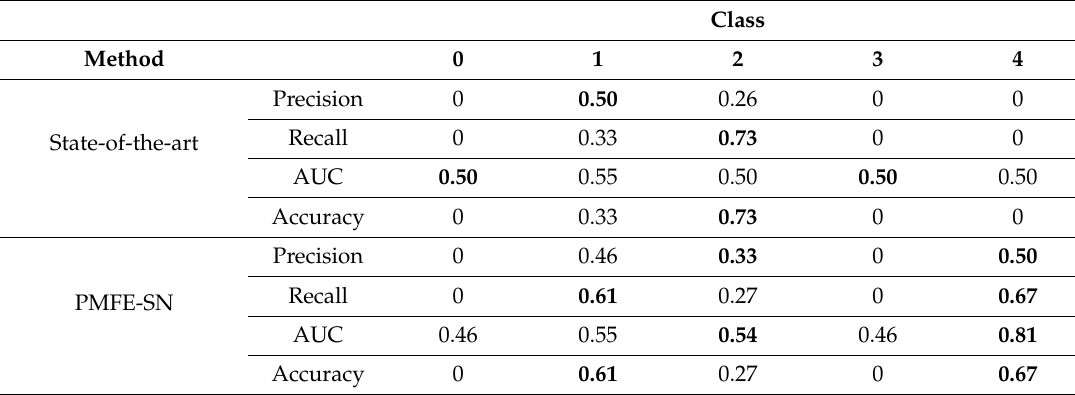
Table 4. Comparison of per class precision, recall, accuracy, and area under the curve (AUC) of state-of-the-art and PMFE-SN on leave one cross-out testing.